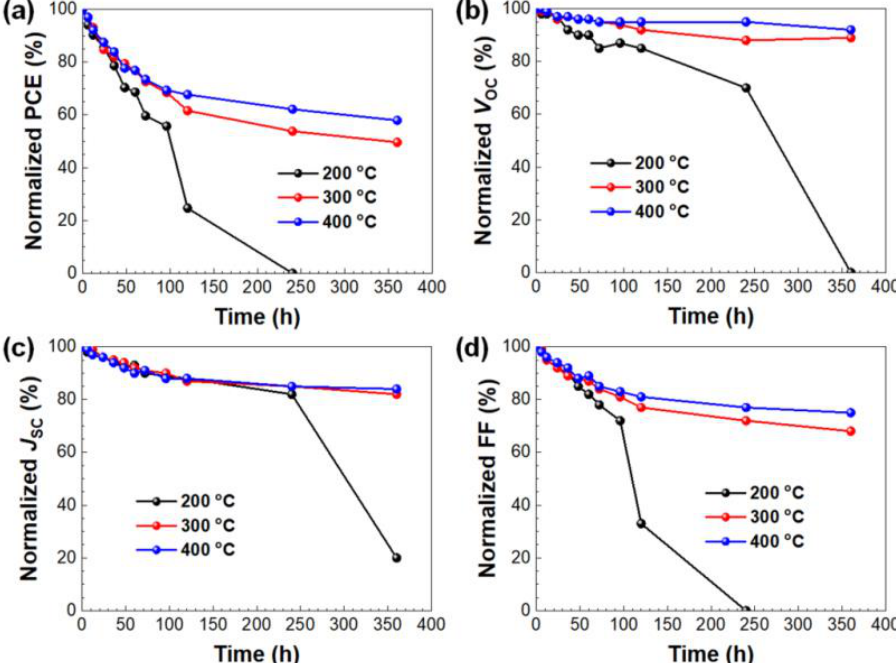
Figure 5. Long-term decay curves of devices in ambient condition: PCE ( a ), V OC ( b ), J SC ( c ), and FF ( d ).